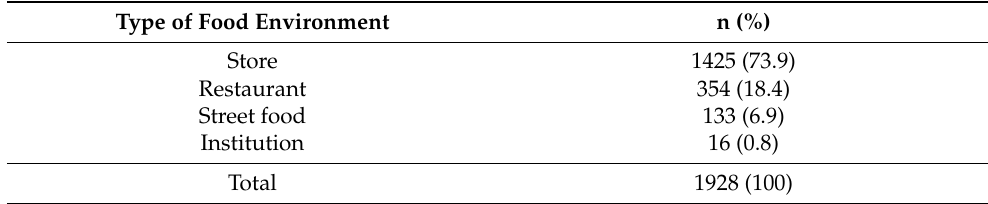
Table 2. Instruments applied to measure food